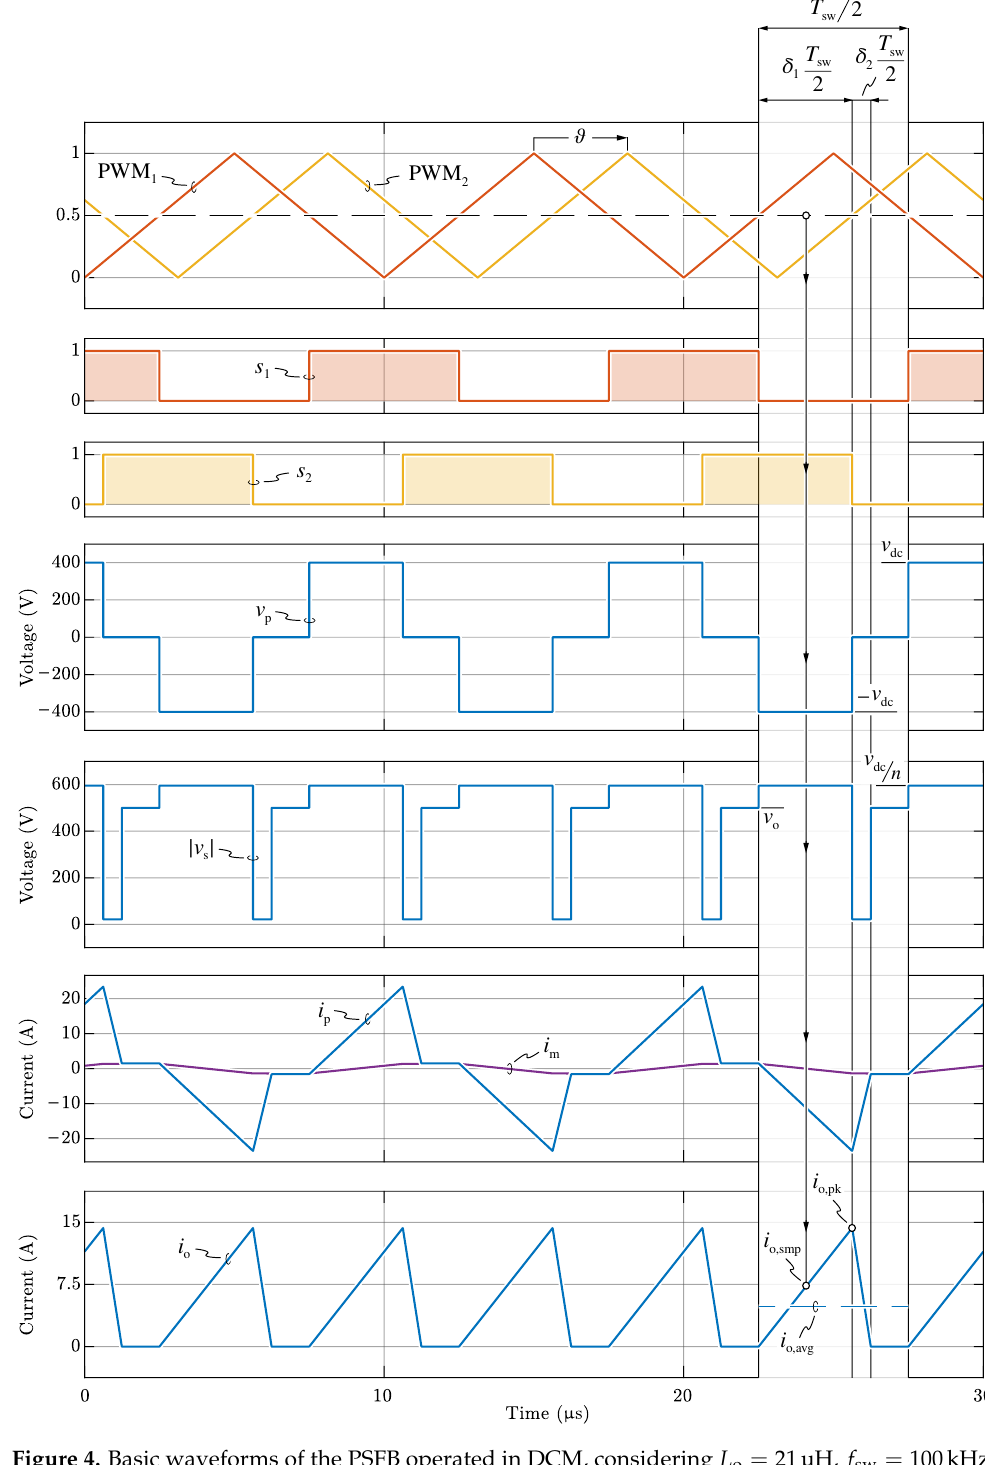
Figure 4. Basic waveforms of the PSFB operated in DCM, considering L o = 21µH, f sw = 100kHz, v dc = 400V, v o = 400V and i o = 5A (refer to Figure 2 for nomenclature). The difference between output average current ( i o,avg ), peak current ( i o,pk ) and sampled current ( i o,smp ) is